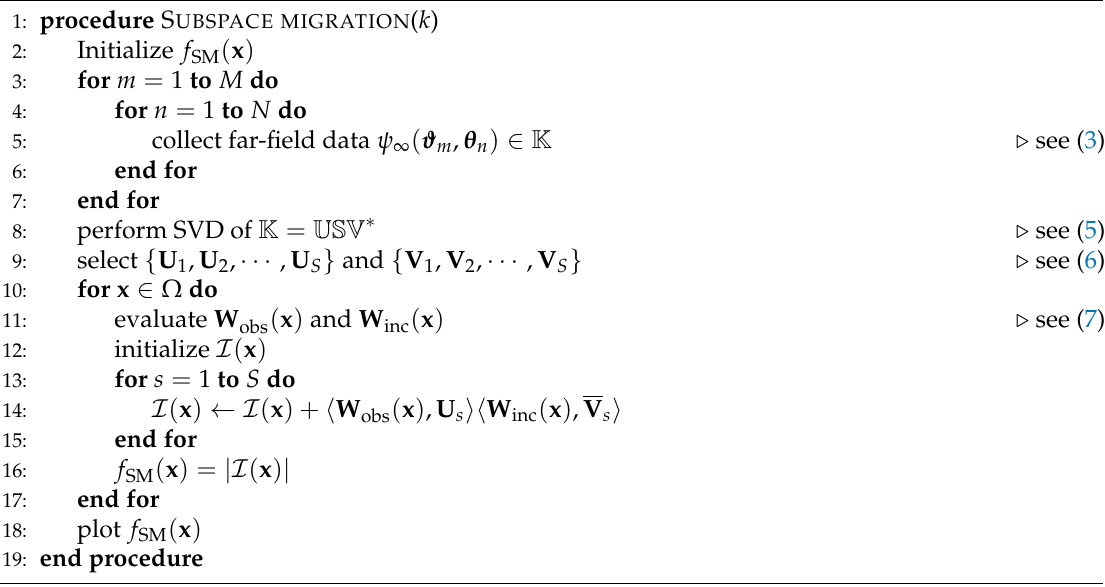
Algorithm 1 Procedure of imaging via subspace migration at given wavenumber k